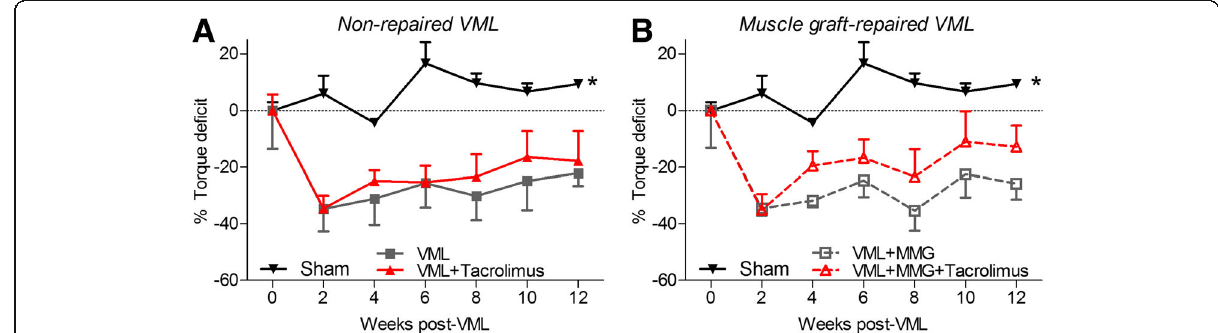
Fig. 2 Peroneus teritus (PT) muscle function was determined by peroneal nerve stimulation in vivo . The percent torque deficit to the pre-injury torque was determined for the ( a ) non-repaired and ( b ) muscle graft (MMG) repaired groups following VML injury and the effect of adjunctive tacrolimus was investigated across these groups. The strength of the sham operated group was consistent over time (duplicated in each panel) and all VML injured groups were less than sham operated. All data analyzed by two-way ANOVA (group p < 0.001; time p = 0.104; interaction p = 0.999). * Significant main effect of group, sham > all other surgical groups. Data are mean ± standard